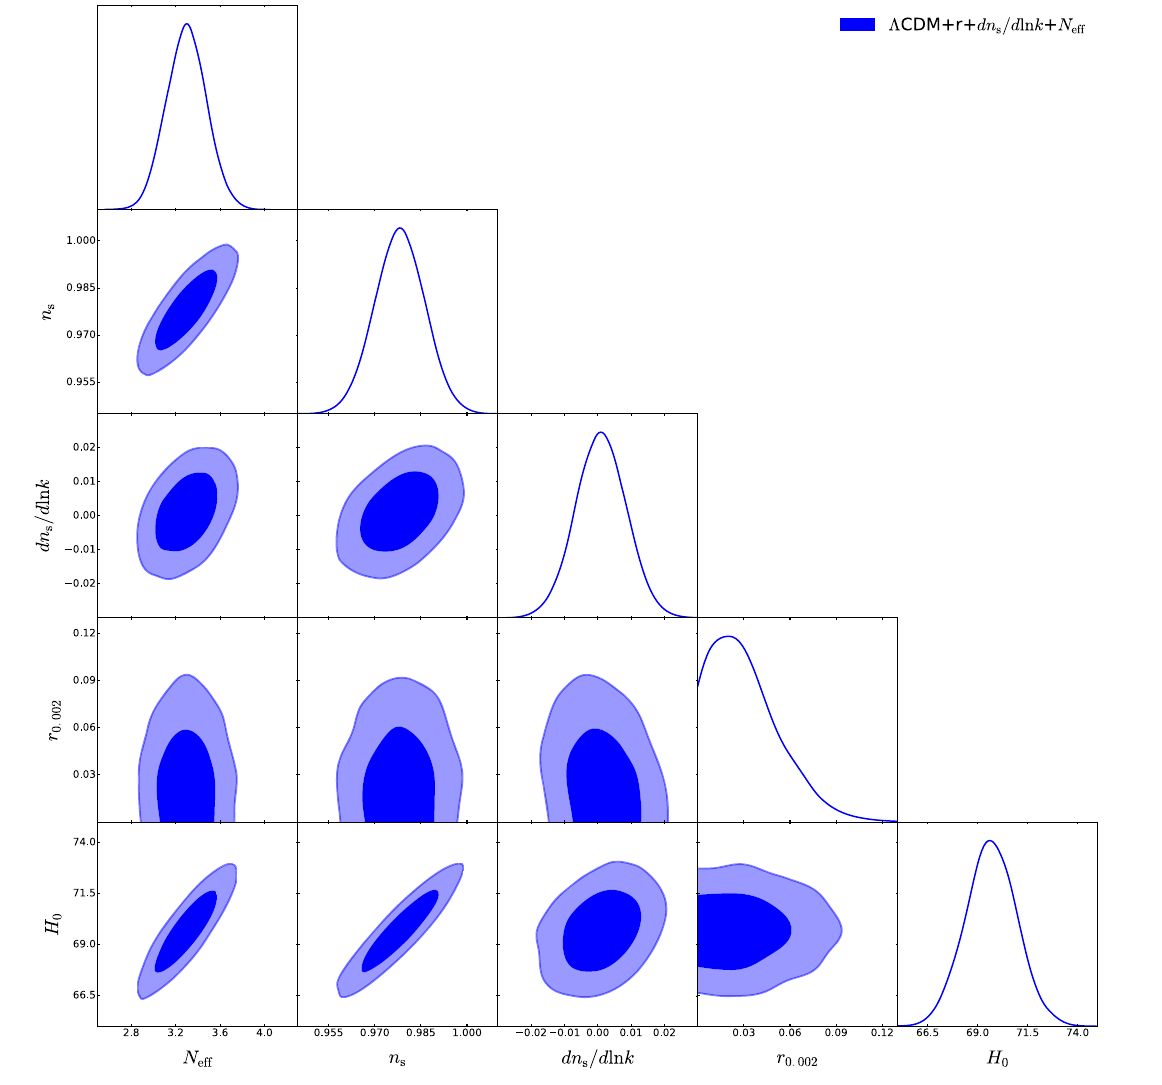
Fig. 5 One-dimensional marginalized distributions and two-dimensional contours (1 σ and 2 σ ) for parameters N eff , n s , d n s / d ln k , r 0 . 002 , and H 0 in the (cid:2) CDM + r + d n s / d ln k + N eff model using the Planck + BK + BAO + H 0